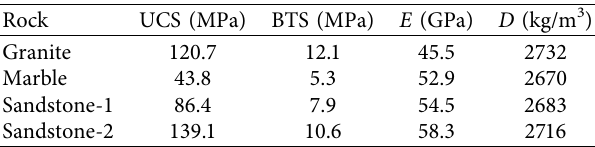
Table 1: Mechanical properties of the